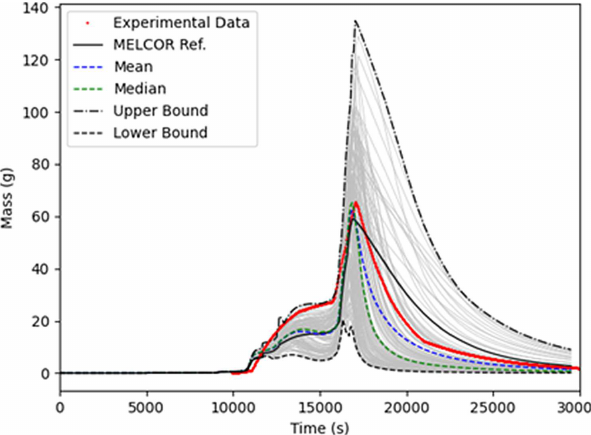
Fig. 7. Airborne particle mass in containment (FPT1)